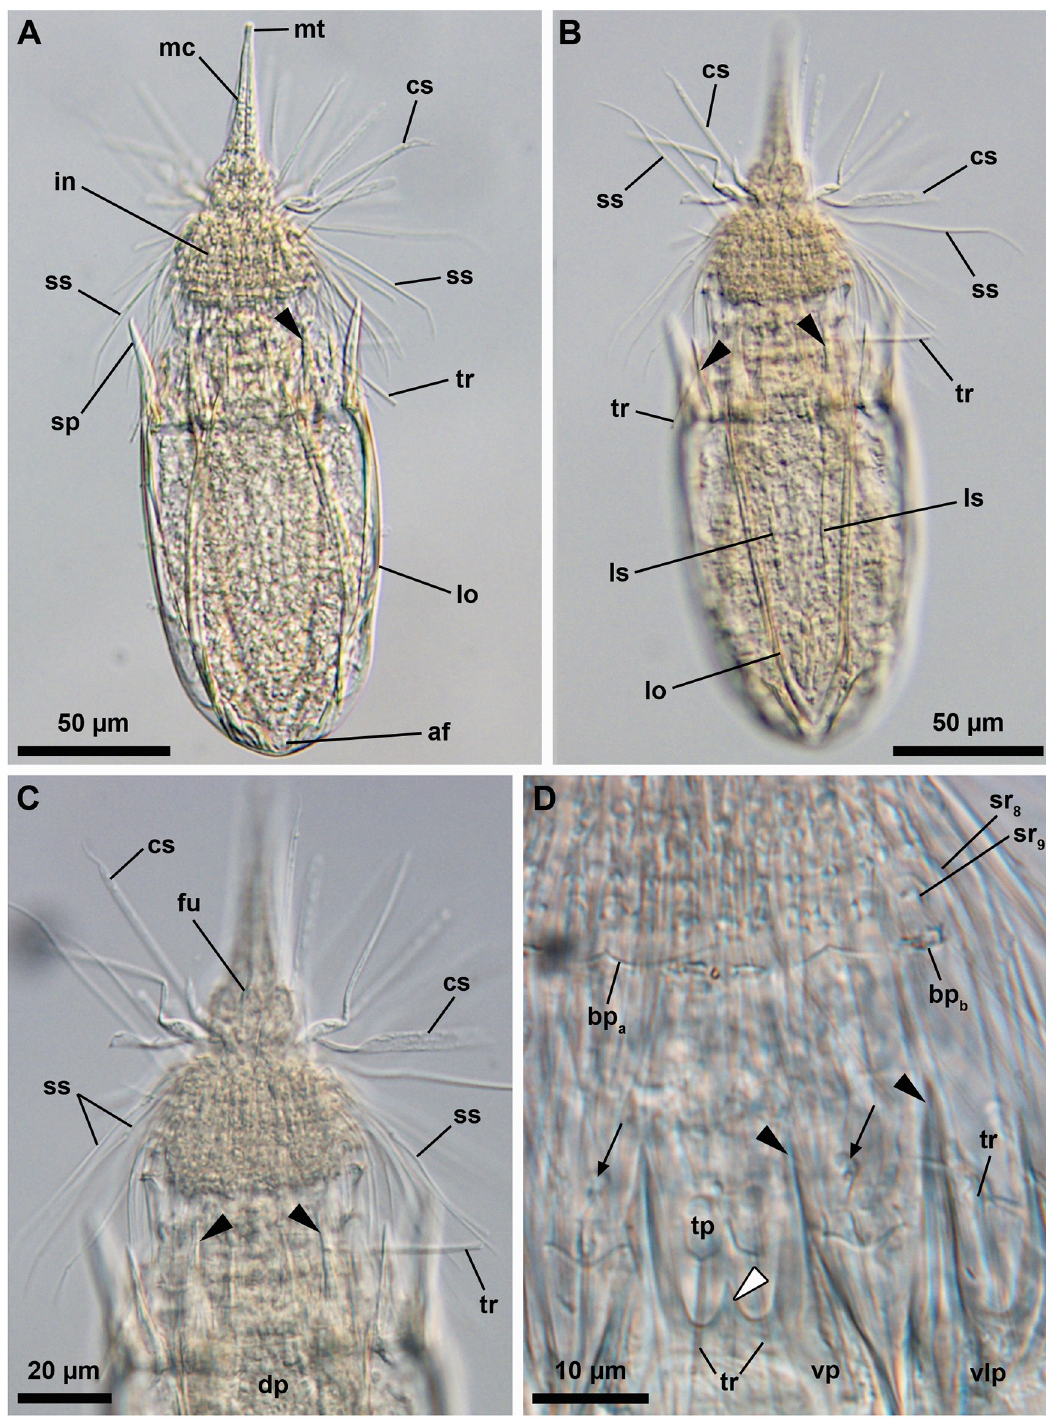
Fig 1. Light micrographs of the holotypic adult male of Nanaloricus valdemari sp. nov. Anterior faces up in all aspects. (A) Ventral view of the extended specimen. Note that the mouth tube is not fully extended. (B) Dorsal view of the specimen. Note the pair of longitudinal stripes (ls) spanning the anterior two thirds of the dorsal plate of the lorica. (C) Anterior region of the specimen, dorsal view. (D) Close-up of the posterior region of the introvert and neck, ventral view. White arrowhead points to the small, midventral anterior spike. Arrows point to trichoscalid sensory organs. Abbreviations: af, anal field; bp a/b , basal plate of type a or b; cs, clavoscalid; dp, dorsal plate; fu, oral furca; in, introvert; lo, lorica; mc, mouth cone; mt, mouth tube; sp (and black arrowheads), anterior spike; sr 8/9 , spinoscalid of 8 th or 9 th row; ss, spinoscalid; tp, trichoscalid plate; tr, trichoscalid; vlp, ventrolateral plate; vp, ventral plate.